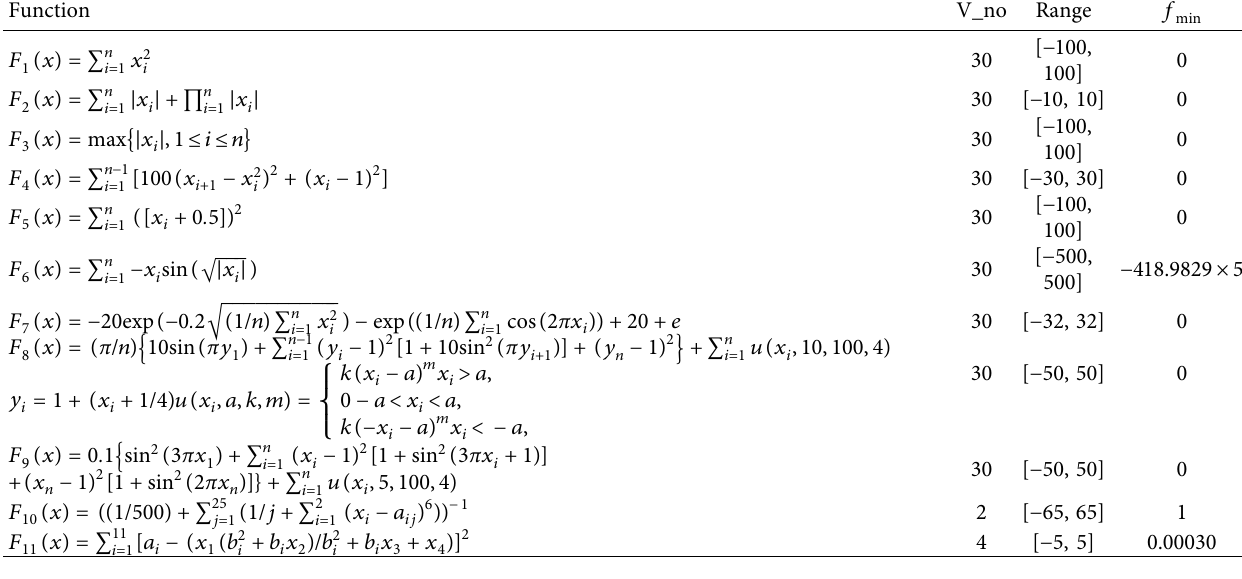
Table 1: Description of benchmark